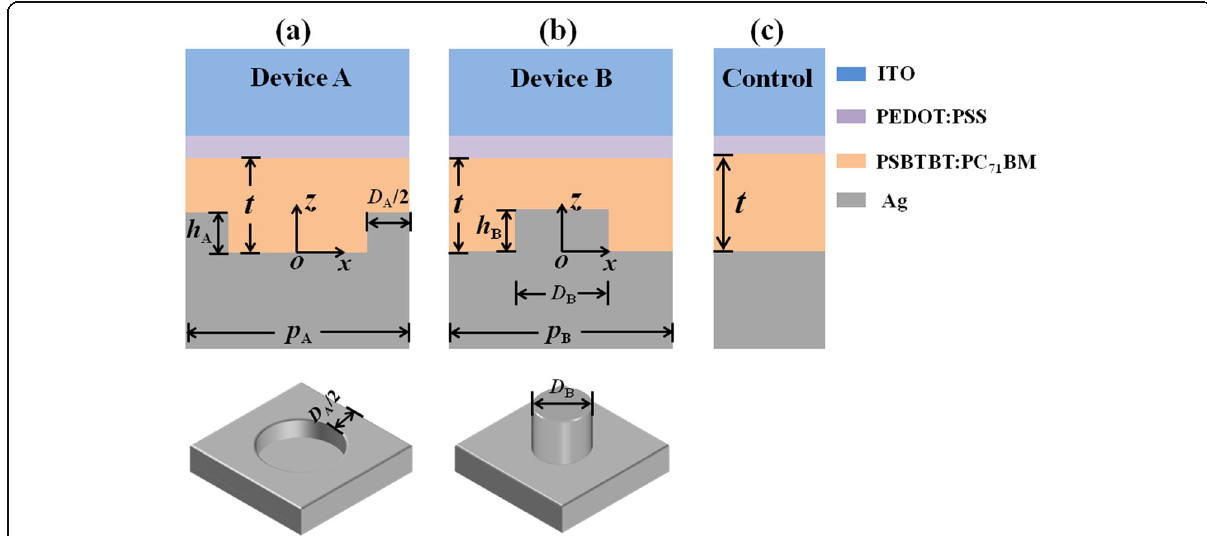
Fig. 1 2D diagrams of the OSCs with nanohole-type PME ( a ) and nanopillar-type PME ( b ) as well as the control ( c ). At the cross section, both PMEs have a protruded metal region with a width of D , height of h , and periodicity of p . The subscripts of A and B represent devices with nanohole-type and nanopillar-type PMEs, respectively. The 3D diagram of the nanohole-/nanopillar-type PME is shown below the corresponding